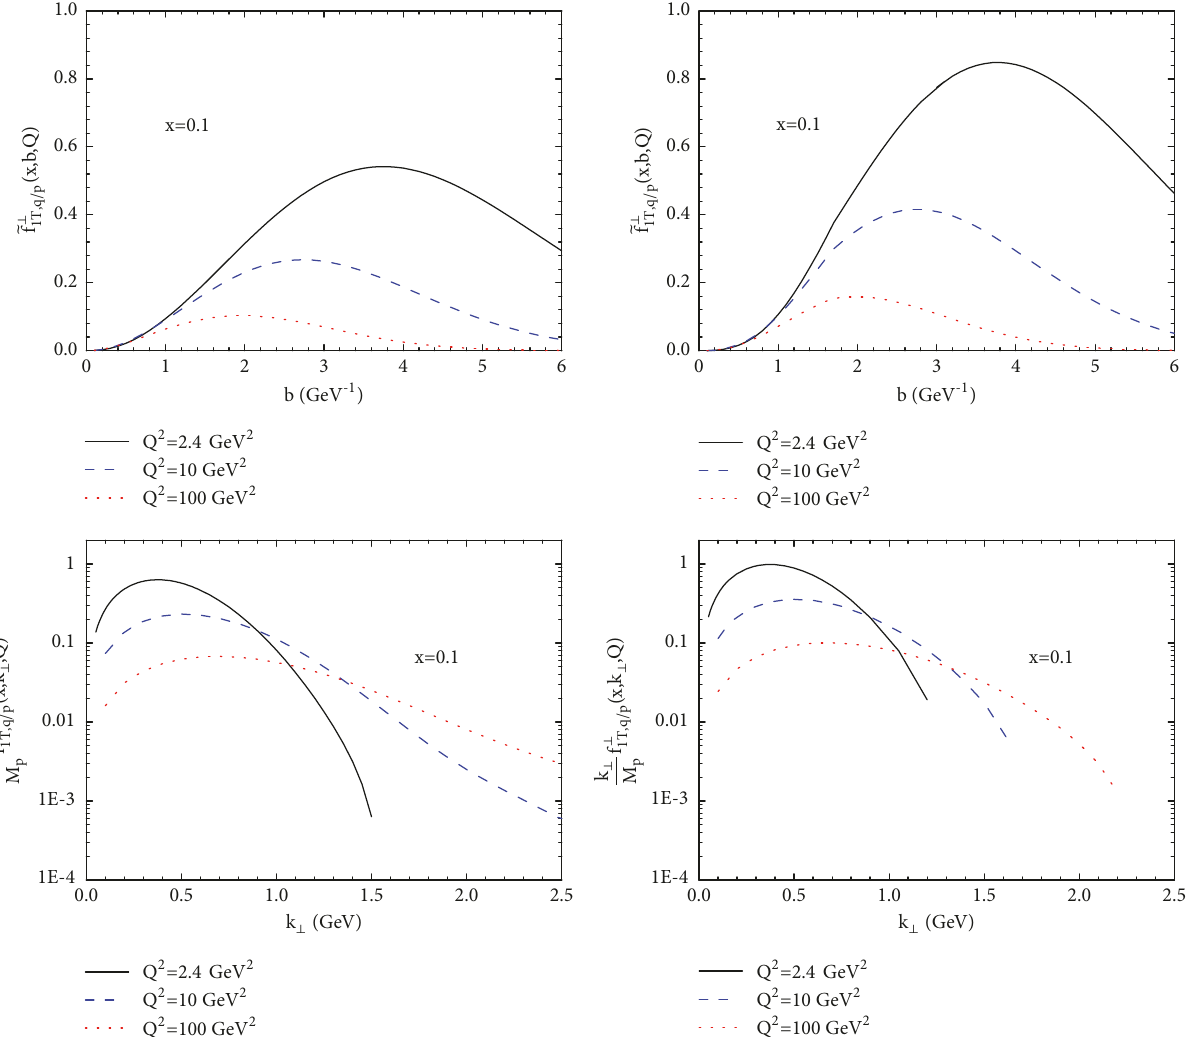
Figure 3: Subtracted Sivers function for the up quarks in Drell-Yan in 𝑏 -space (upper panels) and 𝑘 ⊥ -space (lower panels), at energies: 𝑄 2 = 2.4 GeV 2 (solid lines), 𝑄 2 = 10 GeV 2 (dashed lines), and 𝑄 2 = 100 GeV 2 (dotted lines). The left panel shows the result from the same evolution kernel as that for 𝑓 1 in (66); the right panel shows the result from an approximate evolution kernel for the Qiu-Sterman function in (65), respectively. Figure from